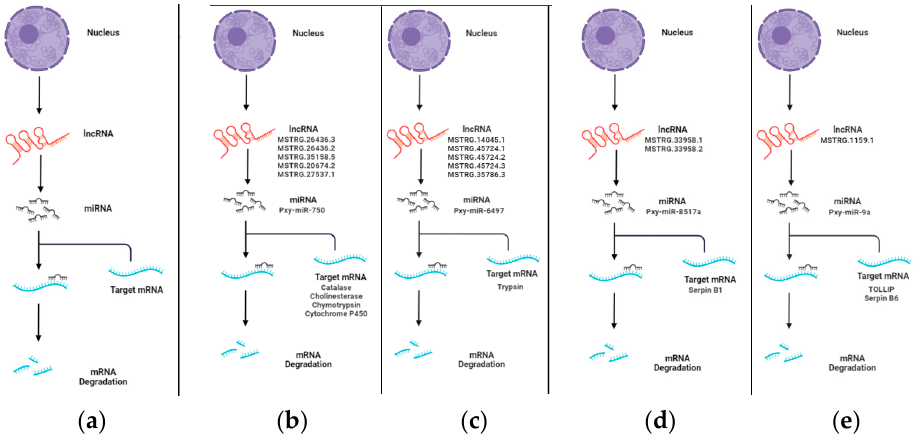
Figure 3. LncRNA-miRNA-mRNA complex. The lncRNA acts as a miRNA precursor, which may participate in mRNA degradation. Key immunity and developmental-related complex are presented here. ( a ) The proposed model of lncRNA acting as miRNA precursor. ( b ) Multiple lncRNAs as the precursor of pxy-miR-750, which can regulate the expression of multiple mRNAs such as catalase , cholinesterase , chymotrypsin and cytochrome p450 . ( c ) Multiple lncRNAs as the precursor of pxy-miR-6497 whose target site was identified in trypsin . ( d ) LncRNAs MSTRG.33958.1/2 as precursors of pxy-8517a which can target serpin B1 ; and ( e ) LncRNA MSTRG.1159.1 as a potential precursor of pxy-miR-9a whose target sites were identified in tollip and serpin B6